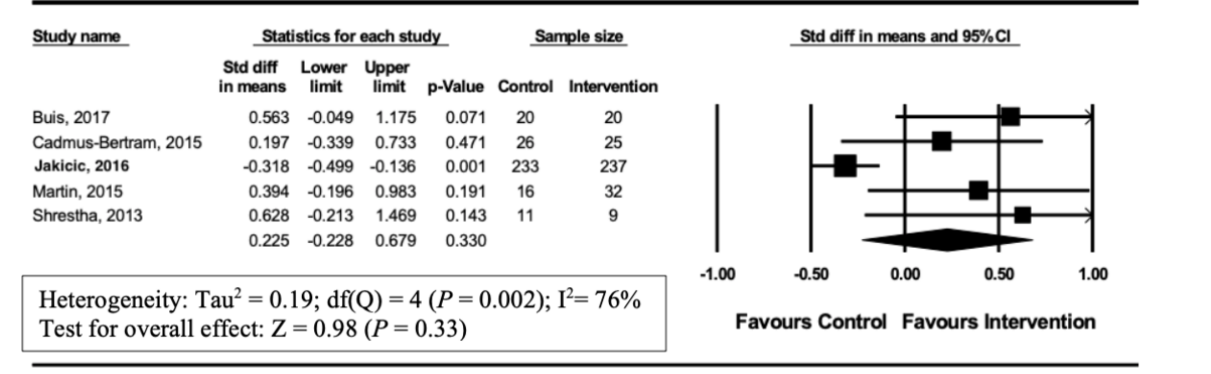
Figure 6. Forest plot of standardized mean difference (95% CI) in the effect of wearable trackers on healthy